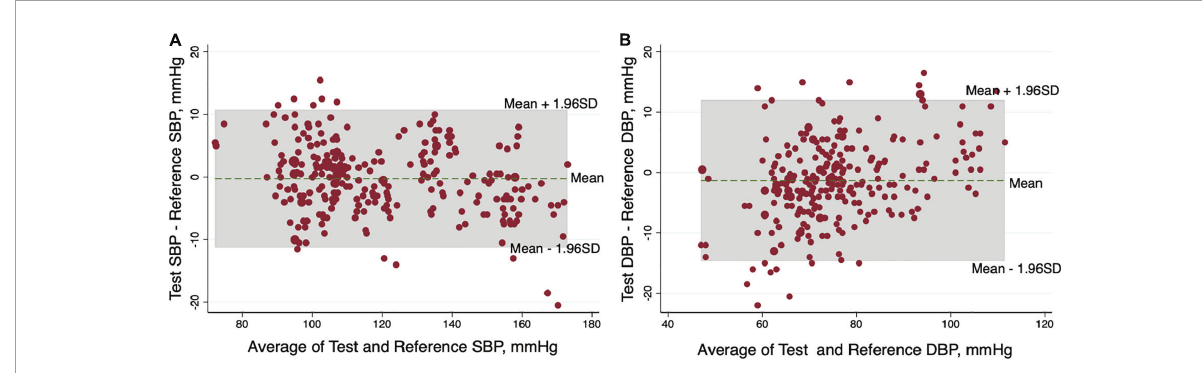
FIGURE3 Bland-Altman plots of the differences between the test blood pressures (BPs) by HUAWEI WATCH and the reference BPs by mercury sphygmomanometer for the systolic blood pressure (SBP) (A) and diastolic blood pressure (DBP) (B)